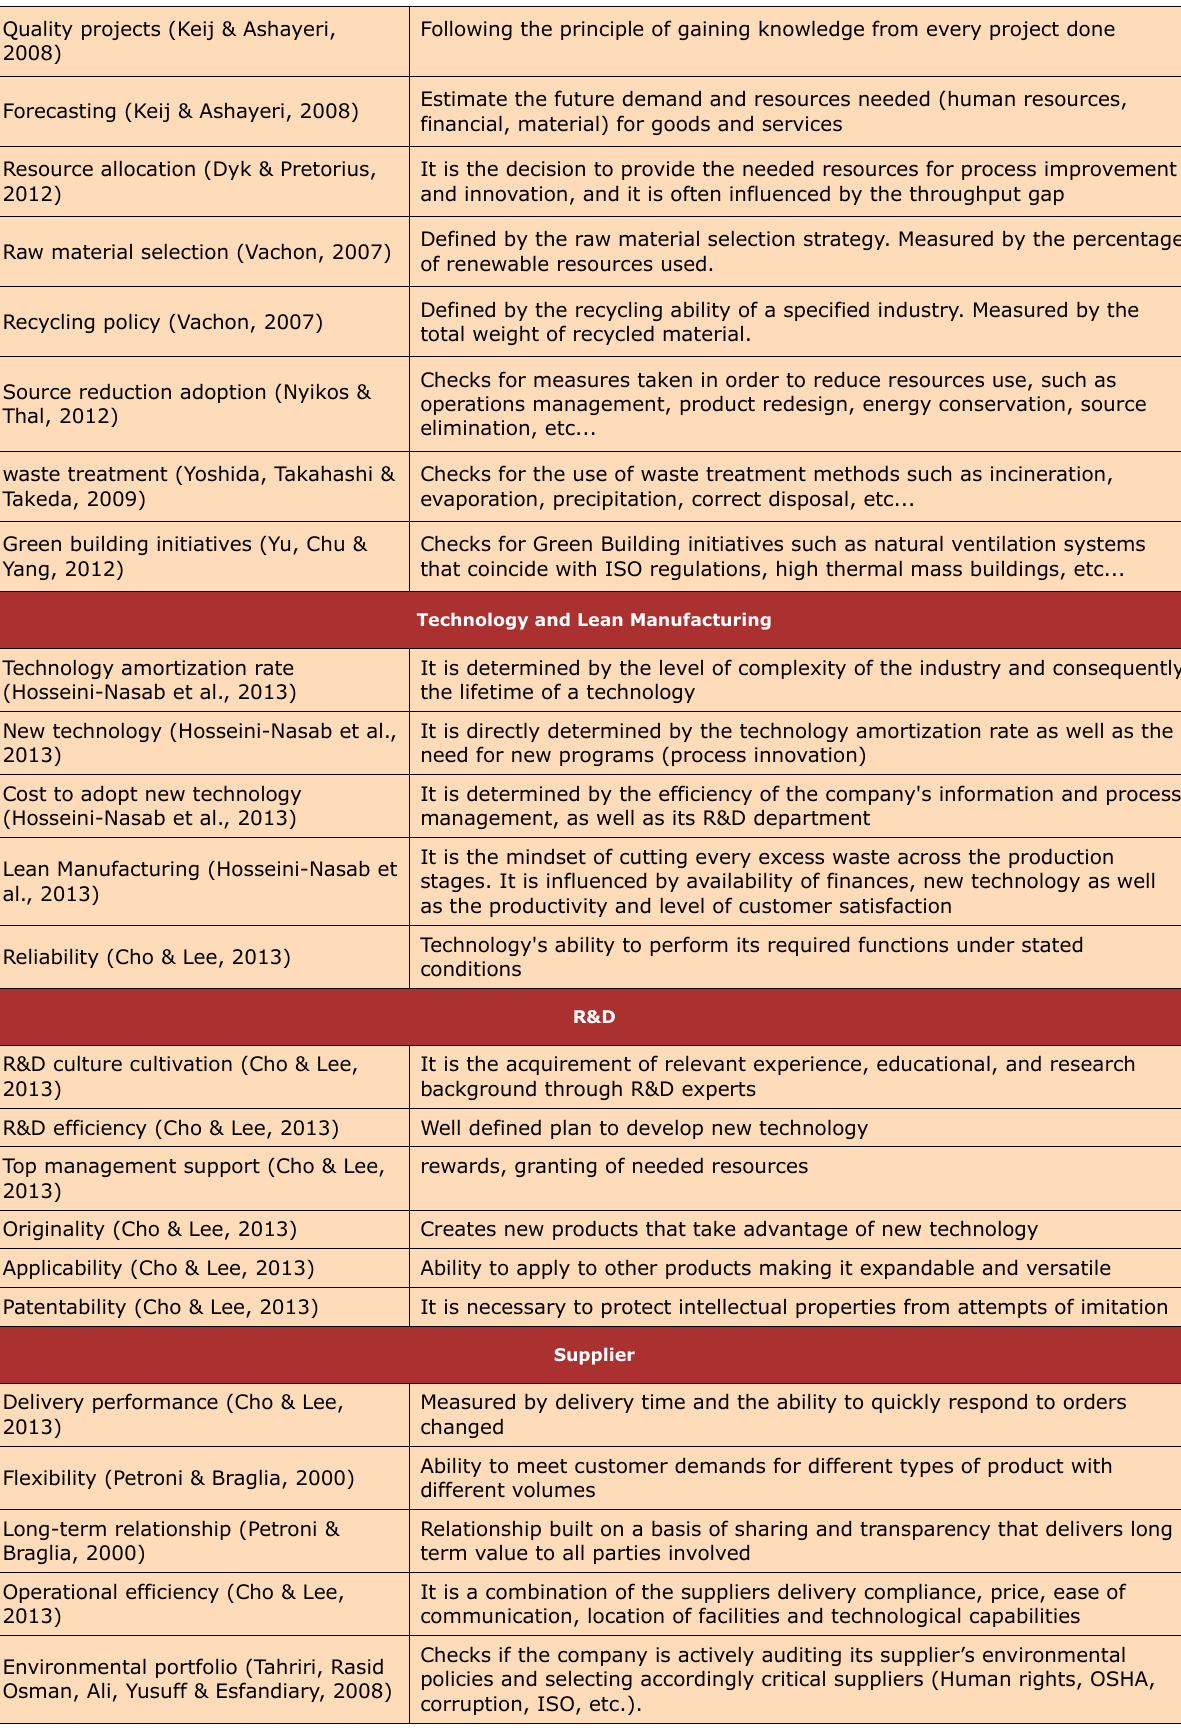
Table 3. Manufacturing